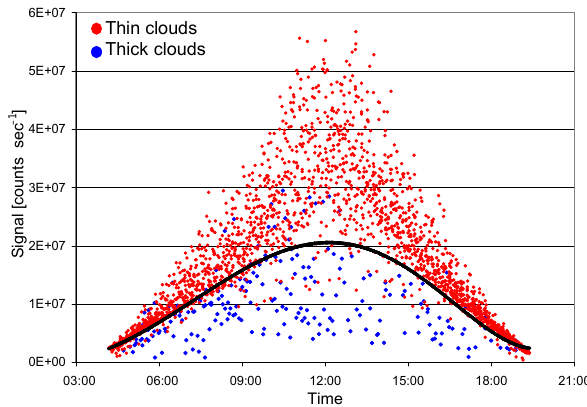
Figure 17. Measured radiance at 360nm (in units of countss − 1 ) for near-zenith observations during the Cabauw campaign. The blue/red dots indicate measurements which were classified as un- der optically thick/thin clouds, based on the calibrated O 4 absorp- tion using the updated thresholds. The black curve represents the threshold value for the radiance used in the original version of the algorithm. The measurements are from the period 12 June to 15 July